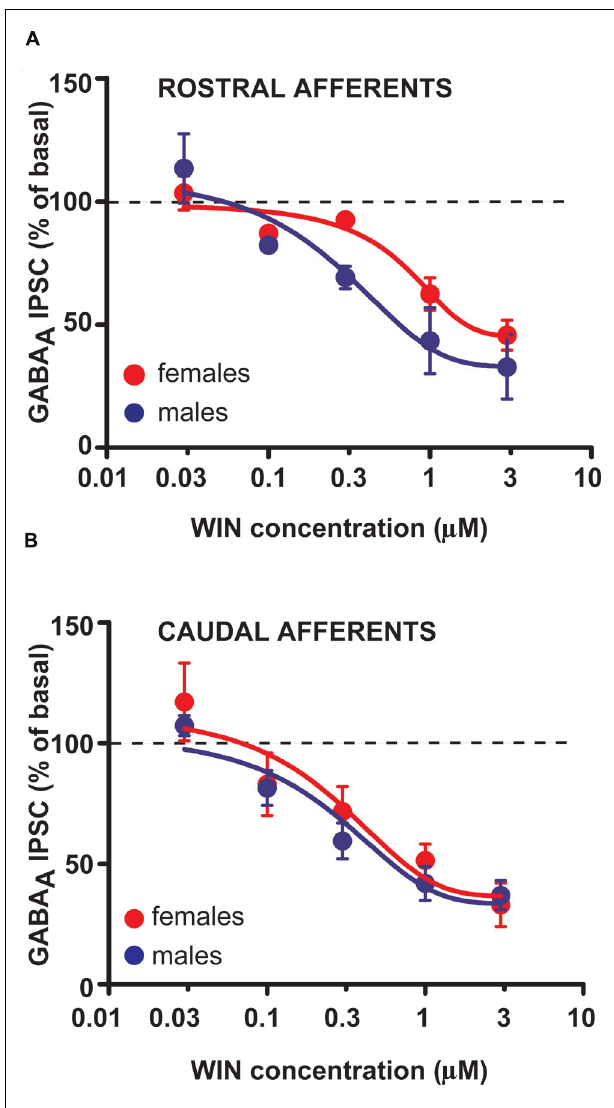
FIGURE 5 | CB1 receptor activation produces similar effects in male and female LH rats. Dose–response curves for percentage inhibition in GABA A IPSC amplitude, which were recorded fromVTA DA cells and evoked by stimulating either rostral (A) ( n = 5 for both sexes) or caudal (B) ( n = 5 for both sexes) afferents, produced by the CB1 receptor agonist WIN. Each symbol represents the averaged value ( ± SEM) obtained from different